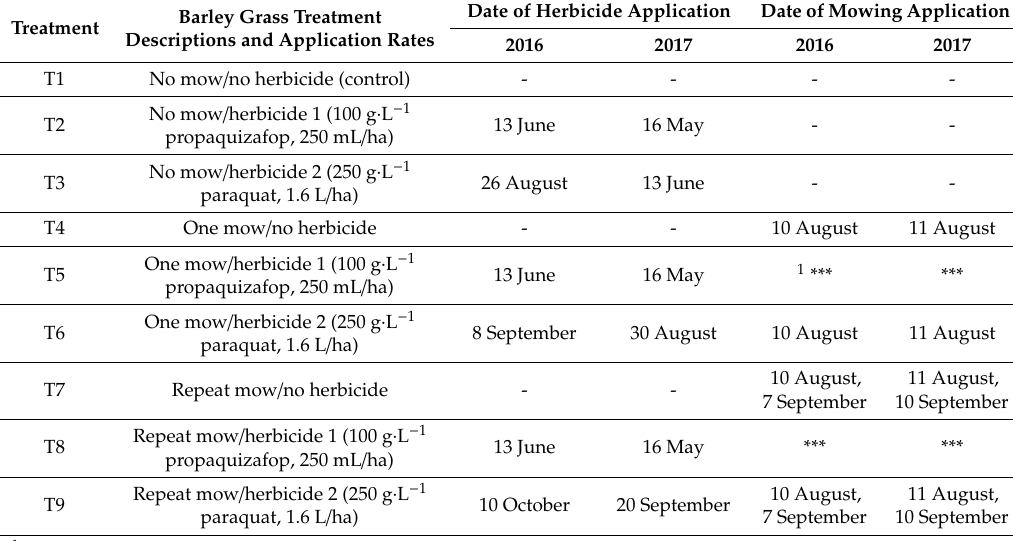
Table 2. Experimental scheme for barley grass defoliation and herbicide treatments including respective treatment